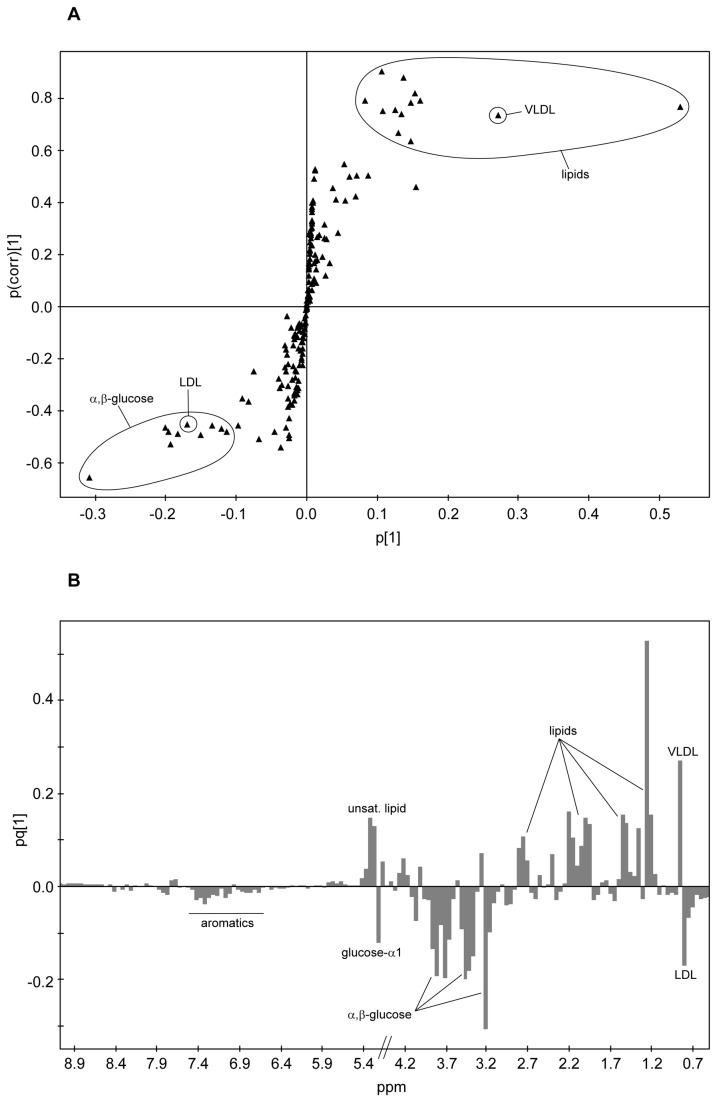
Early IUGR.(a) Representation of the OPLS-DA loadings in the form of an S-plot: the magnitude of each loading, p, is represented against its reliability p(corr).Those loadings (NMR buckets) showing high magnitude and reliability are encircled. (b) OPLS-DA loadings plot displayed as columns. Chemical shift is represented against magnitude of the loading. Reliability is evaluated by jack-knife 95% confidence intervals (not shown in the figure for clarity reasons). Positive loadings correspond with metabolites present in increased amounts in the case subjects; negative loadings correspond with metabolites in lower concentrations.